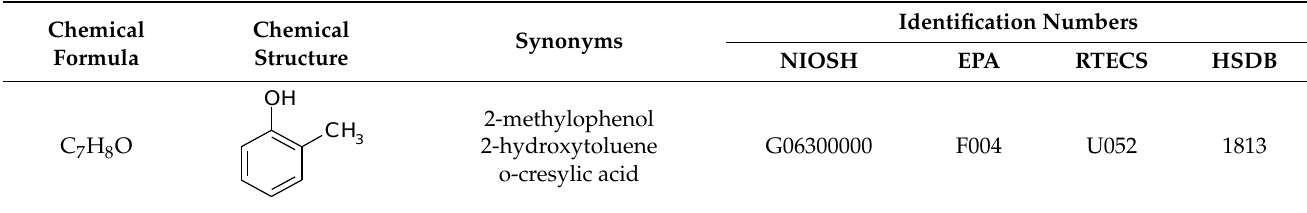
Table 2. Chemical identity of o -cresol .